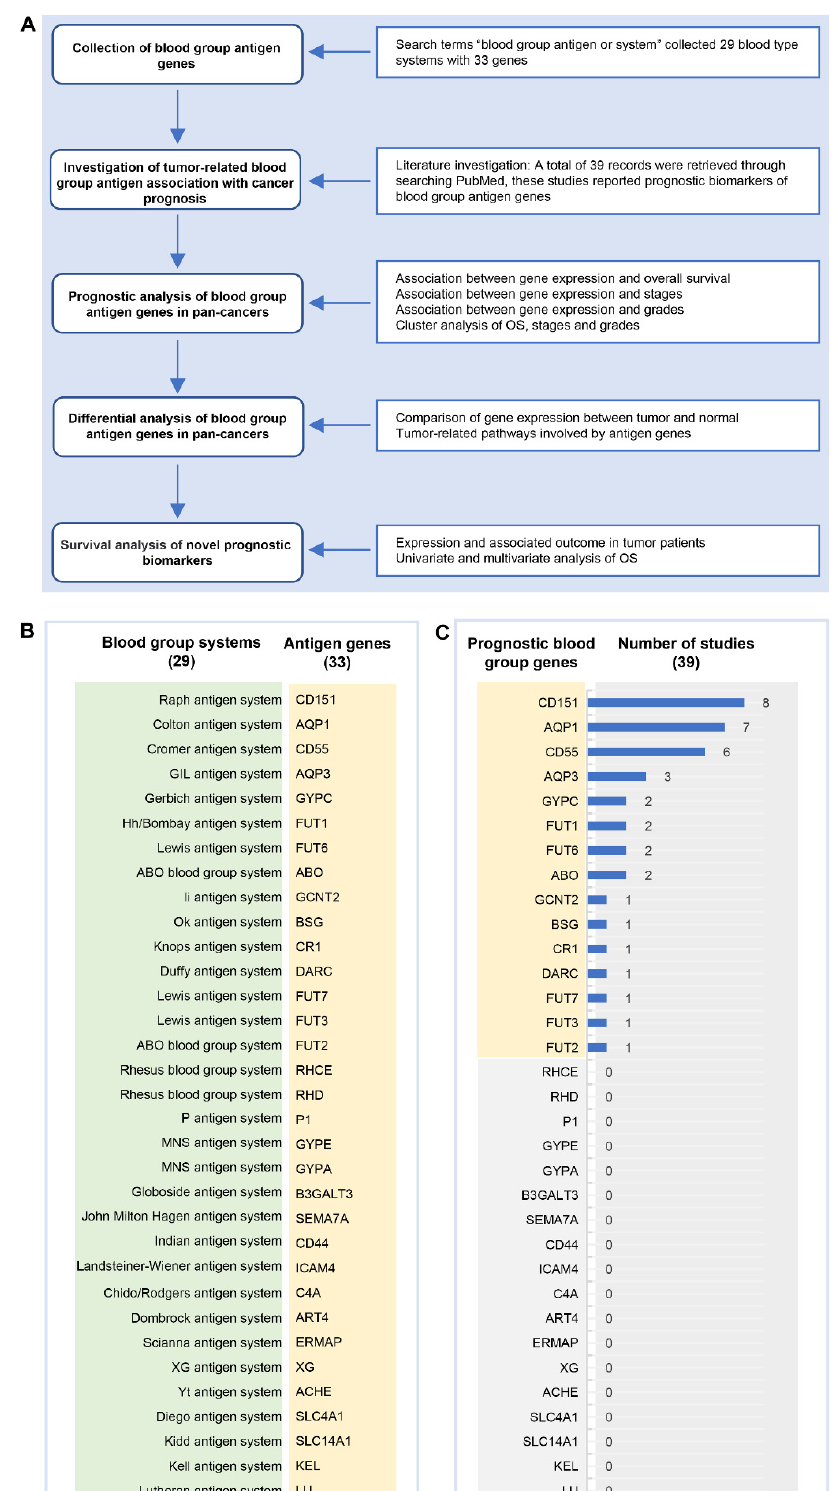
Figure 1. The flow diagram of this study. ( A ) The schematic diagram shows how the analysis route of the prognostic value of blood group antigen genes in pan-cancers was calculated. ( B ) The chart shows that 33 blood group antigen genes in 29 blood group systems were analyzed in this study. ( C ) The frequency of published records of blood group antigens as cancer prognostic markers.